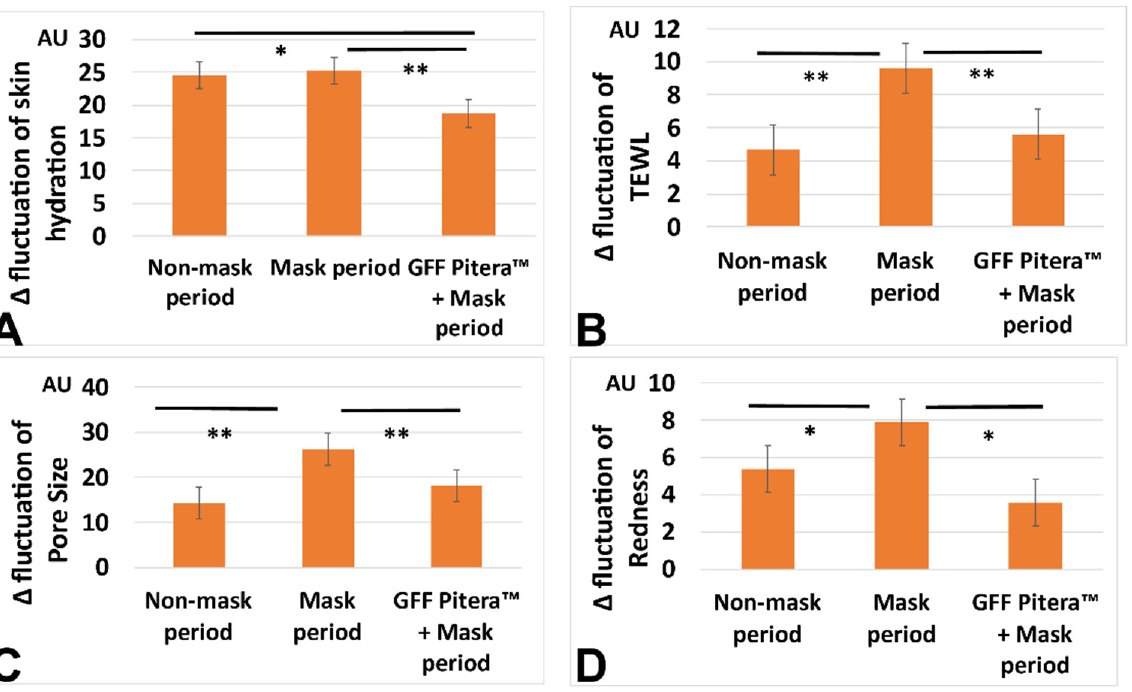
Figure 3. Effects of moisturization on the Δ fluctuation in skin hydration ( A ), Δ fluctuation in TEWL ( B ), Δ fluctuation in pore size ( C ), and Δ fluctuation in redness ( D ). *; p < 0.05. **; p < 0.01.